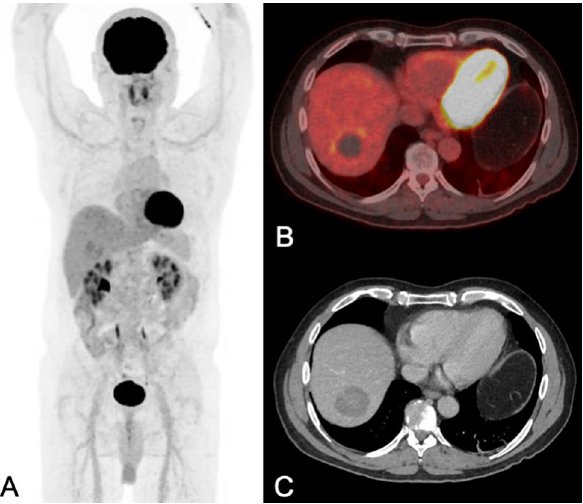
Figure 2. PET/CT performed for staging of alveolar echinococcosis in a 55-year old man (patient 02 in Table 3) showed mild metabolic activity [in maximum intensity reconstructions of PET ( A ) and fused PET/CT images ( B )] at the margins of a round and hypodense lesions in the right liver lobe [as shown on axial contrast- enhanced CT images in ( C )]. SUVmax was 4.7 in the echinococcosis manifestations, and 3.2 in non-infected liver tissue; SUVratio was 1.5. After 1000 days of benzimidazole therapy, levels of Em-18 antibodies became undetectable, but therapy was not yet stopped at the end of the present study period (in total after 1131 days of